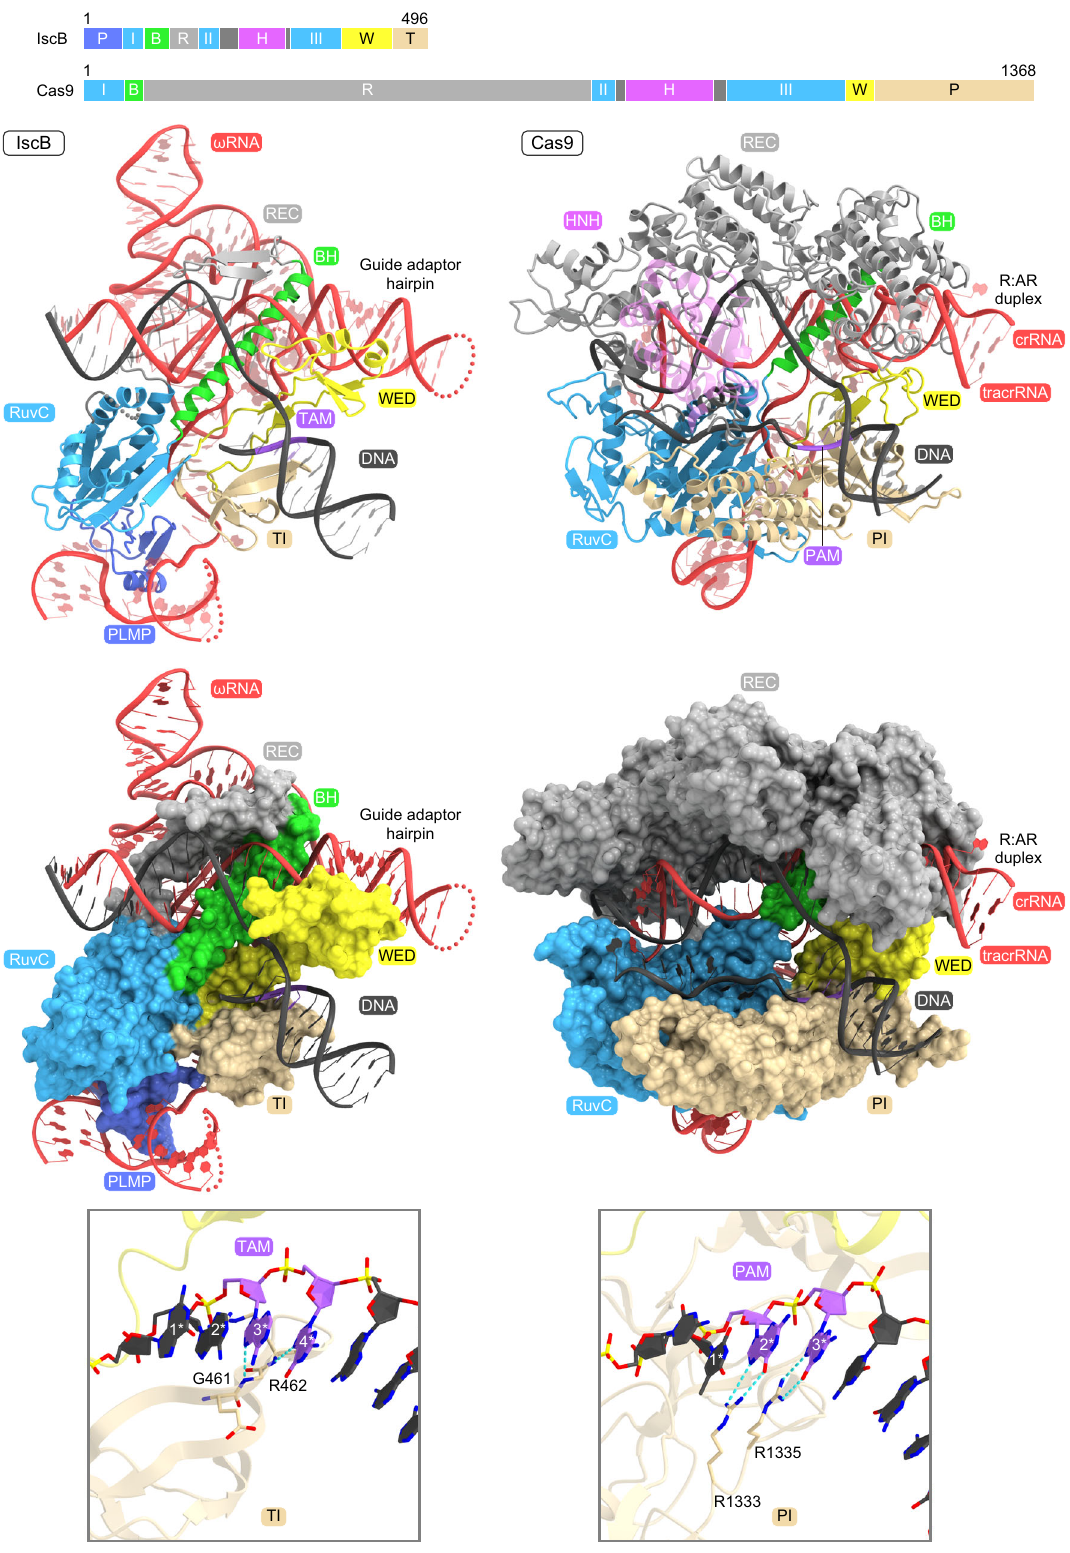
Fig. 5|StructuralcomparisonofIscBandCas9. Thestructuresof IscBand SpCas9(PDB:5F9R)werealigned,based ontheirRuvCdomains.TheHNHdomainofCas9is colored semi-transparent magenta for clarity. P PLMP, I – III RuvC-I – III, B bridge helix, R REC, H HNH, W WED, T TI, P DNA complex was puri fi ed by chromatography on a Superdex 200 Table 2). The puri fi ed IscB – ω RNA complex (A 260 of 3) was incubated with the target DNA (5 µ M) at 37°C for 40 min. The IscB – ω RNA – target